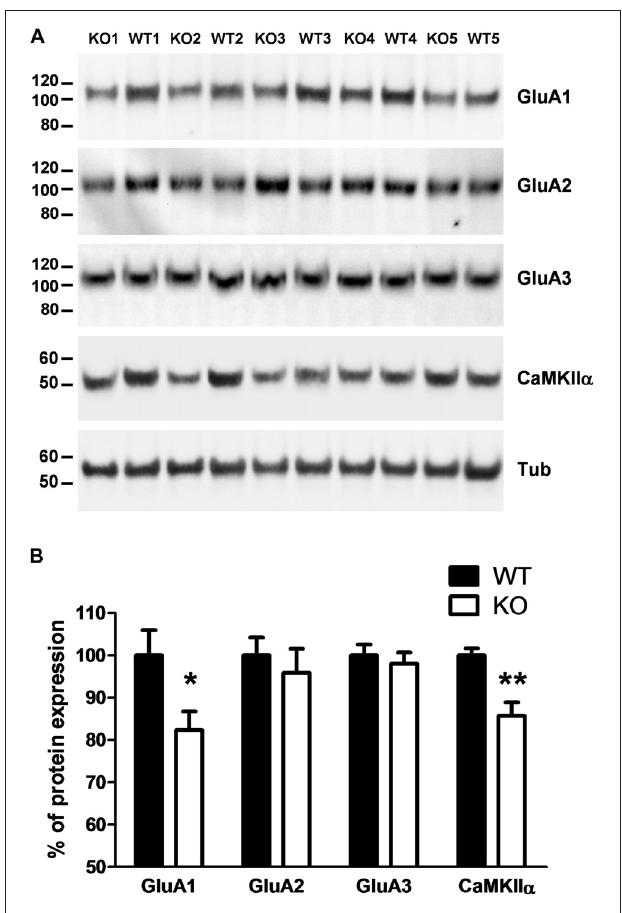
FIGURE 4 | PROT − / − mice show altered expression of synaptic proteins in cortex. (A) Western blot analysis of cortex crude synaptomes (P2) prepared from WT and PROT − / − (KO) animals. Equal amounts of protein (20 µ g/lane) were loaded and probed with the indicated antisera. (B) Quantitative analysis of the immunoreactive bands corrected by β -tubulin ( n = 12 mice for each genotype; ∗ p < 0.05; ∗∗ p < 0.01; two-tailed Student’s t test). Data are shown as means ±